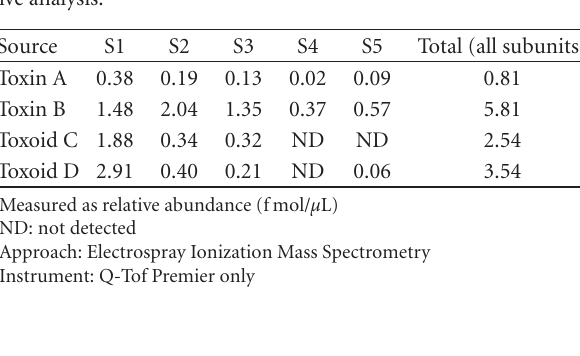
Table 5: Comparative pertussis toxin and toxoid subunit quantita- tive